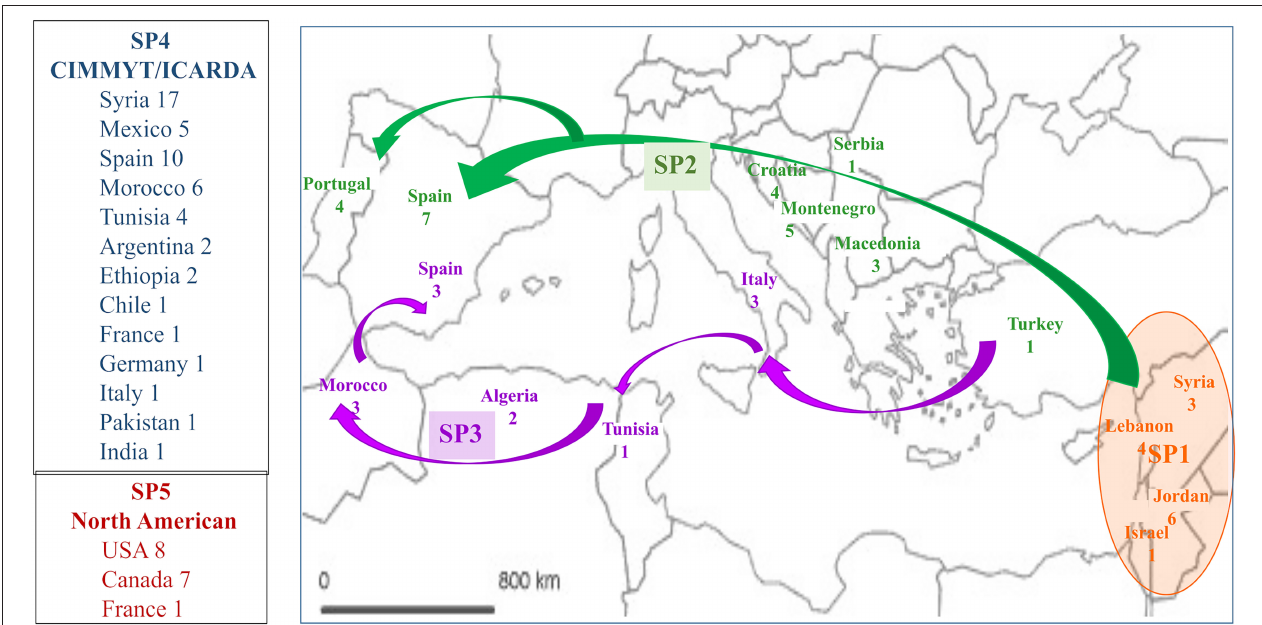
FIGURE 2 | Origin of the 120 accessions with a membership coefficient q > 0.80 to each of five genetic subpopulations. SP1, SP2 and SP3 include landraces from the area of wheat domestication and the routes of expansion of wheat cultivation within the Mediterranean Basin (Feldman, 2001). SP4 and SP5 (on the left side of the map) include modern cultivars. Numbers indicate the number of accessions from each origin.